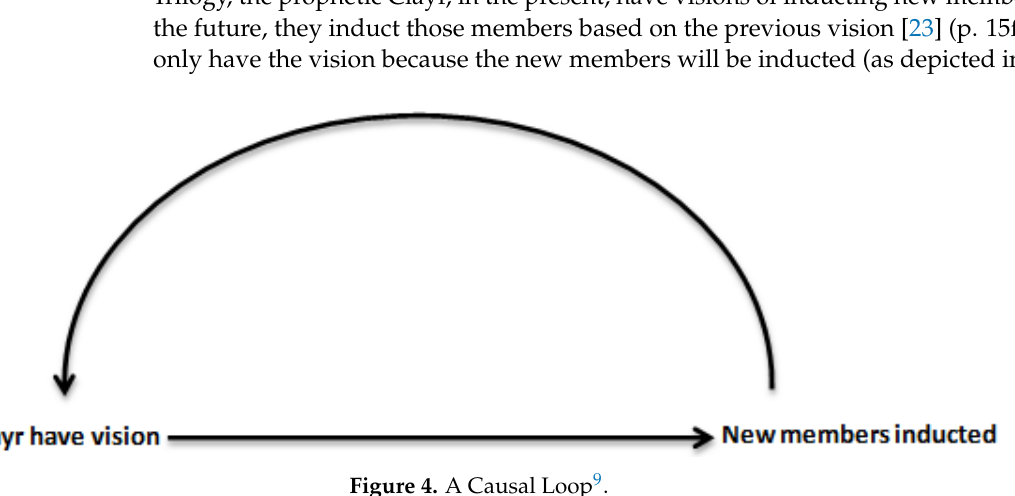
Figure 3. Divine foreknowledge without loop.